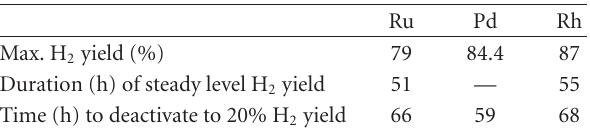
Table 1: Performance summary of the monometal-supported reforming